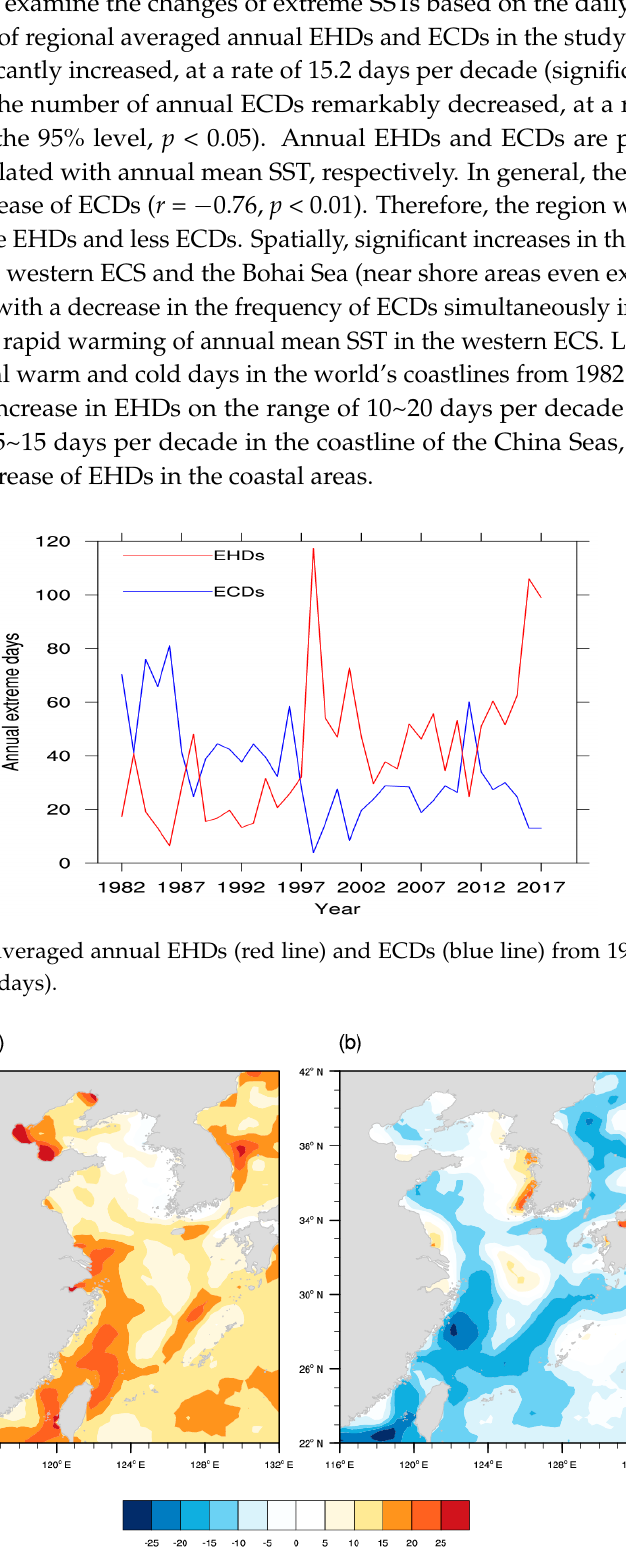
Figure 7. Linear trends of the annual EHDs ( a ) and annual ECDs ( b ) during 1982–2017 (Units: days per